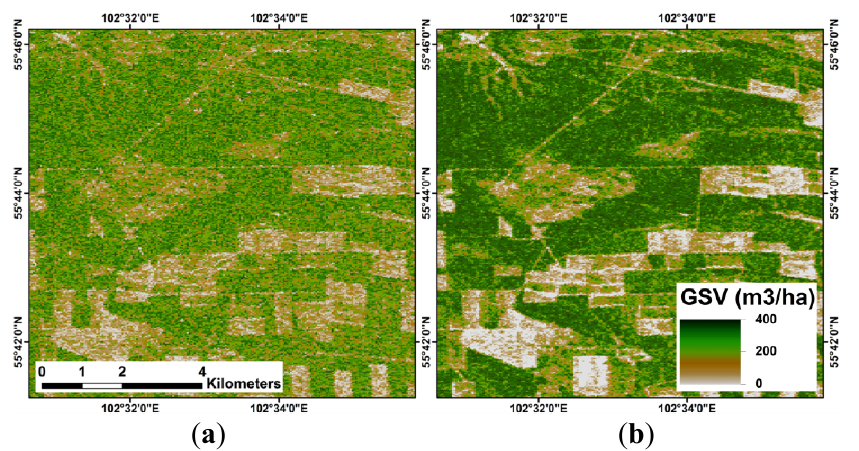
Figure 5. Detailed comparison of the mapping results for the 2007 map ( a ) and the multi-temporal result ( b